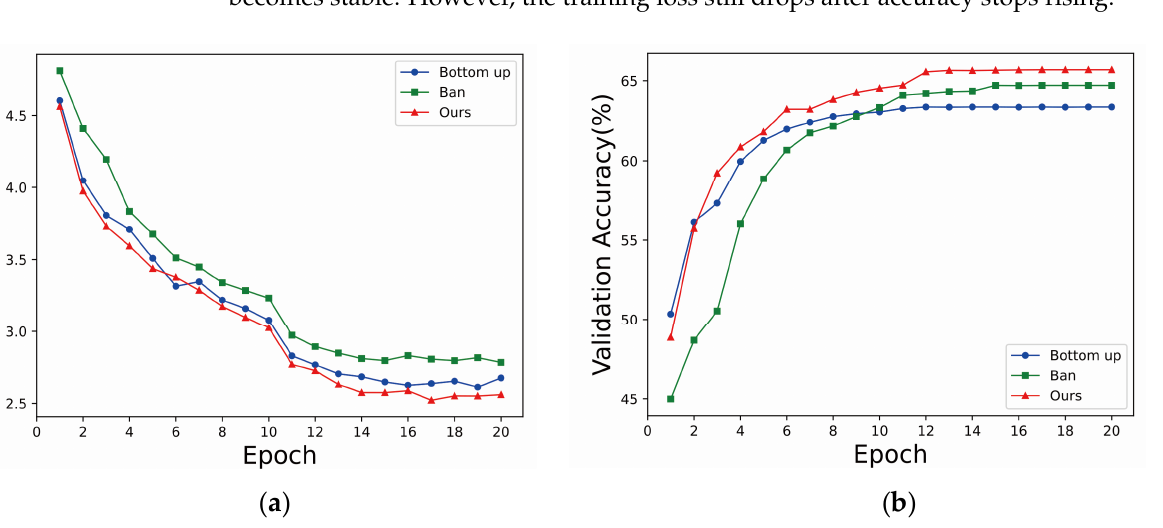
Figure 5. ( a ) The training loss of our model vs. epoch of Bottom-Up and Ban; ( b ) The validation accuracy of our model vs. epoch of Bottom-Up and